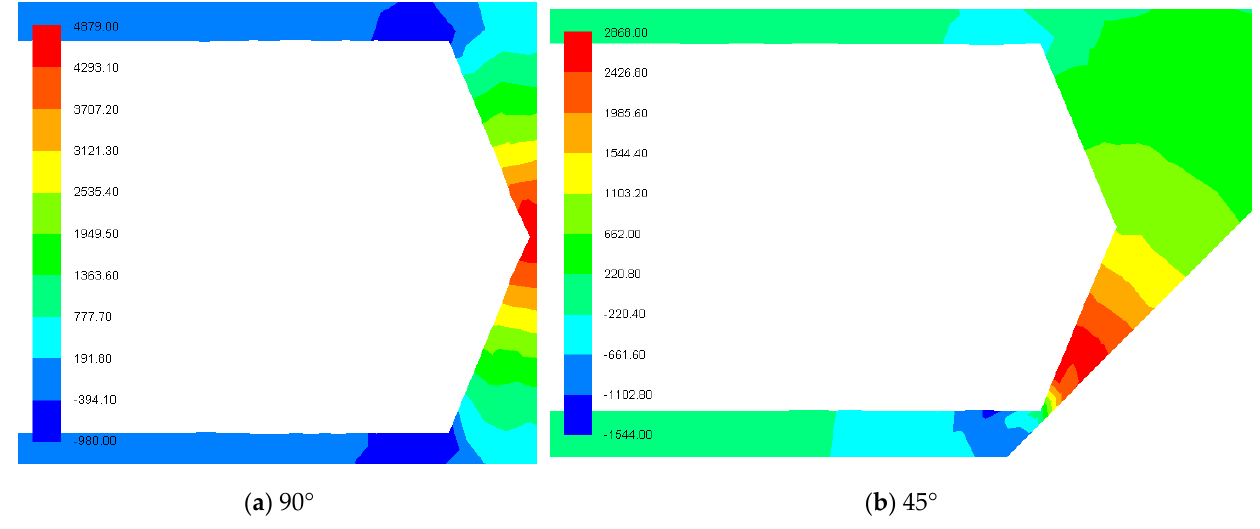
Figure 10. Pressure distribution of the two different shooting angles: ( a ) 90° and ( b ) 45°, at a speed of 30 m/s.